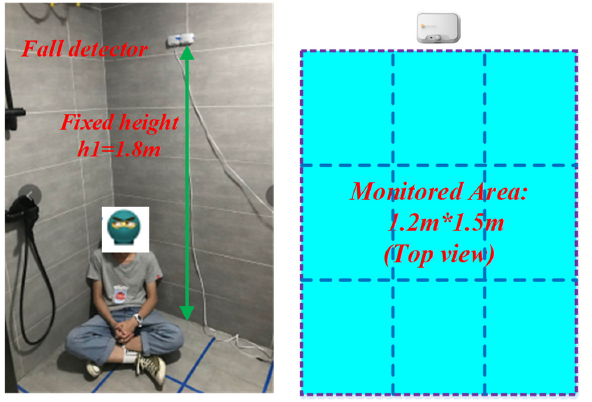
Figure 5. The actual effective monitored area in the bathroom is about 1.2 m by 1.5 m.